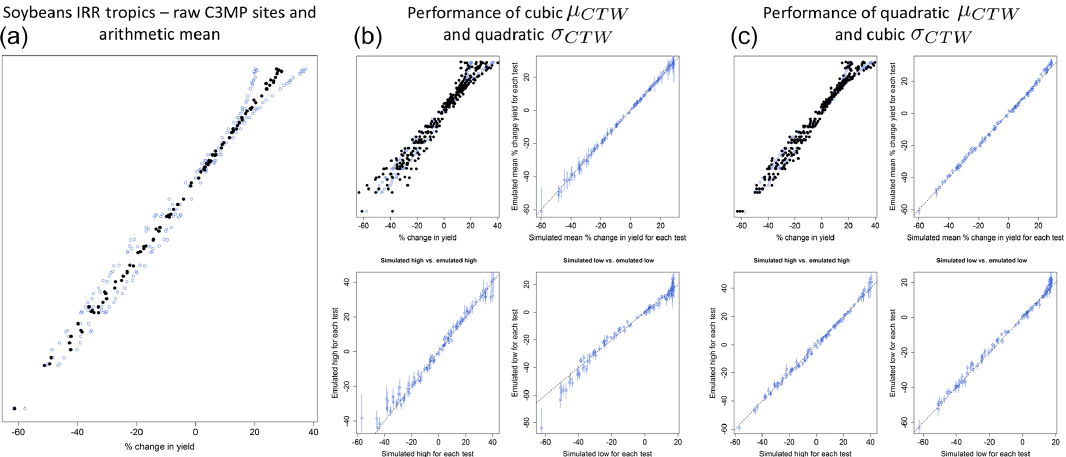
Figure 6. (a) The spread of yield responses for the two C3MP sites making forming the irrigated soybeans in the extended tropics production group. (b) The performance dashboard of the shared optimal functional form (Table 1) for this production group. (c) The performance dashboard of the group-specific optimal functional form (Table A10) for this production group.